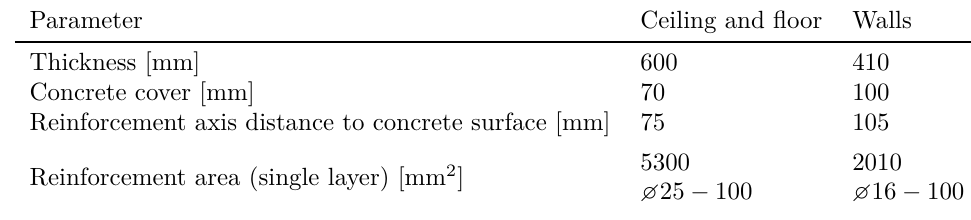
Table 1. Tunnel cross-sectional characteristics (per unit length).